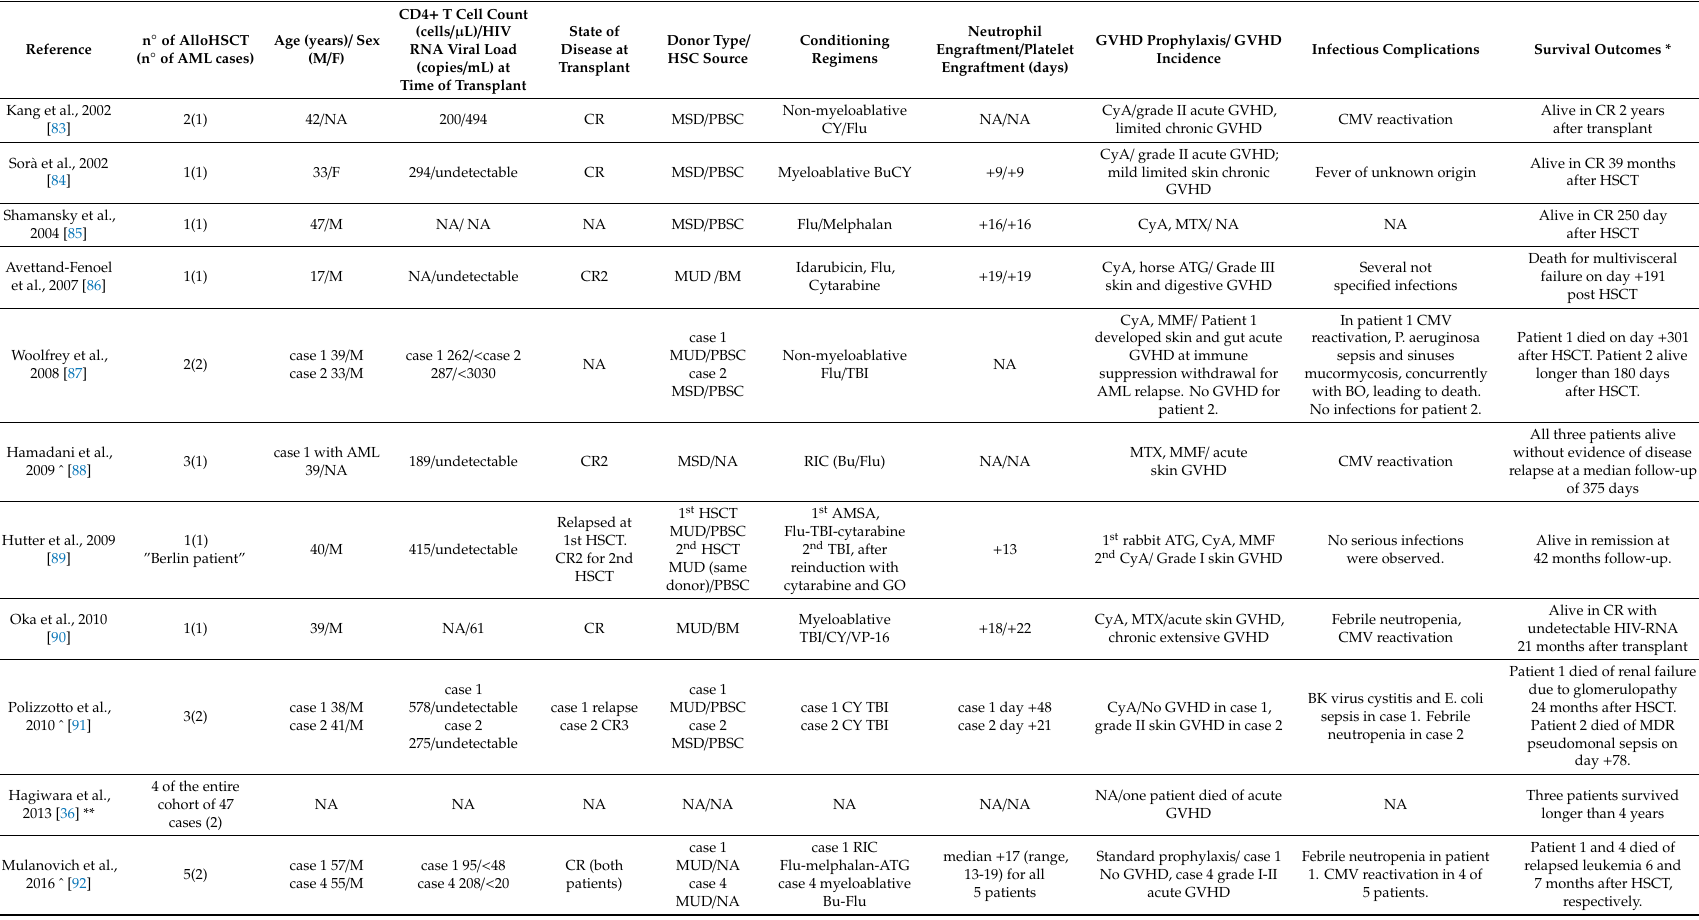
Table 4. Allogeneic HSCT in patients with acute myeloid leukemia and HIV infection in the ART era.